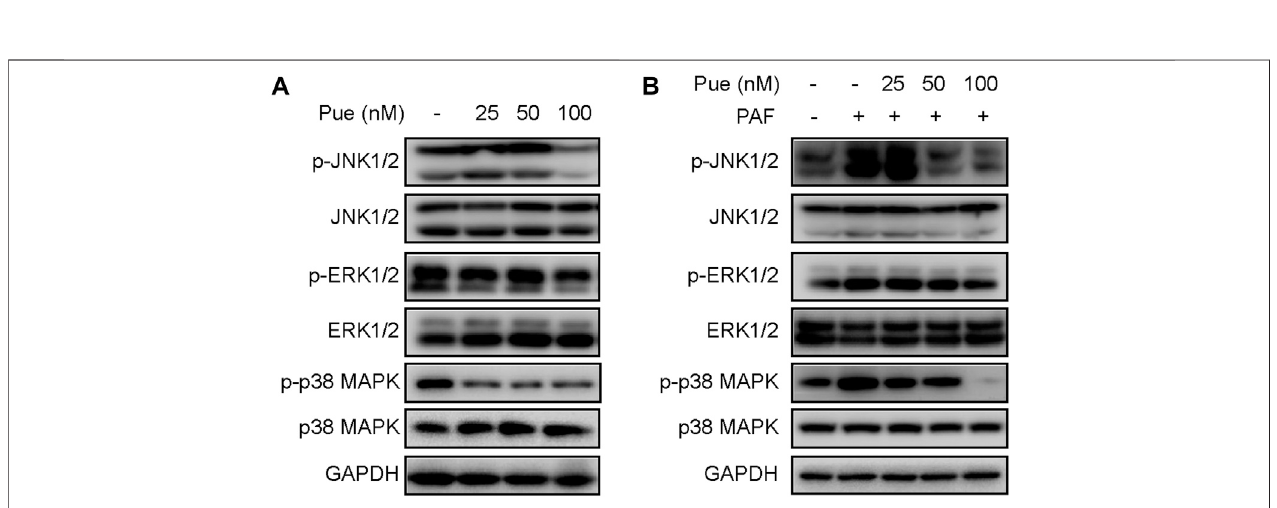
FIGURE 7 | Puerarin suppressed the activity of MAPK cascades in HPSCs. (A) The total proteins and phosphorylation proteins expression levels of MAPK family proteins (includingJNK1/2, ERK1/2 and p38 MAPK)weretested inHPSCs after treatmentwith different doses ofpuerarin (25, 50, 100 nM) for 24 h byWestern blotting analysis. (B) The total proteins and phosphorylation proteins expression levels of MAPK family proteins were tested in HPSCs after stimulation of PAF (10 nM) and treatment with different doses of puerarin (25, 50, 100 nM) for 24 h by Western blotting analysis.